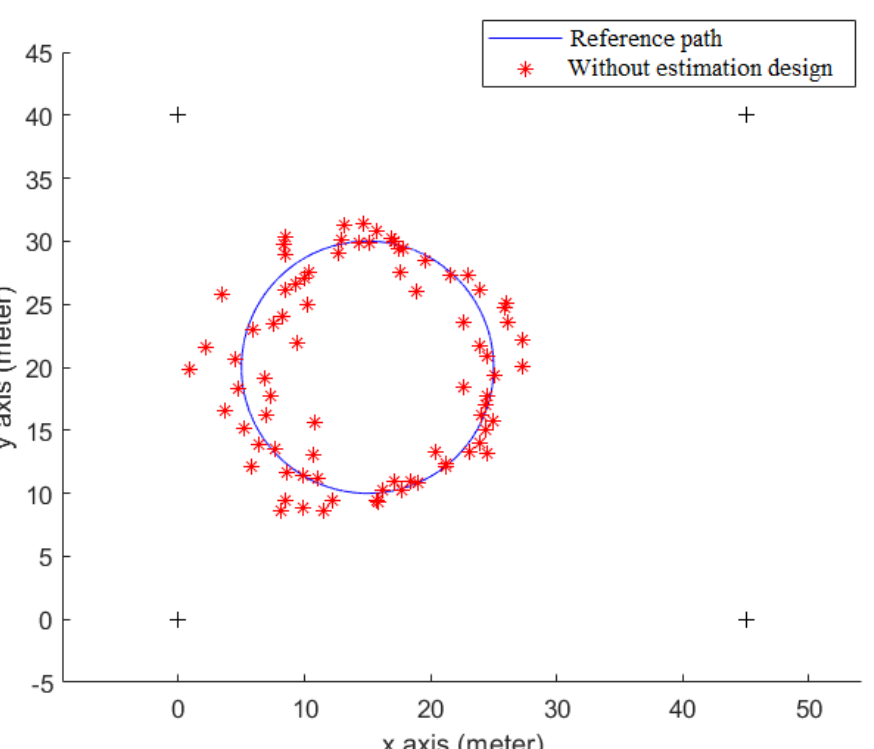
Figure 7. A circle path for the indoor positioning test.